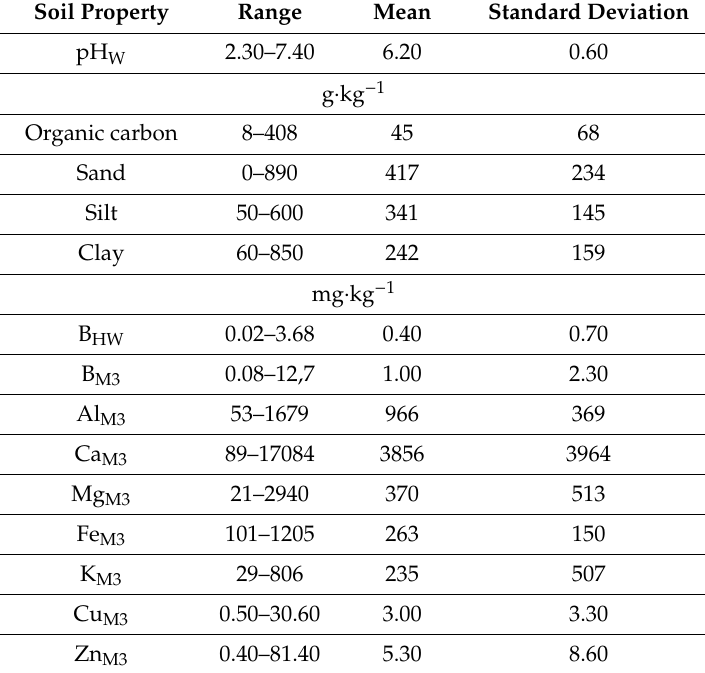
Table 1. Selected properties of the 365 soil samples in the plough layer (0–20 cm) (Data base